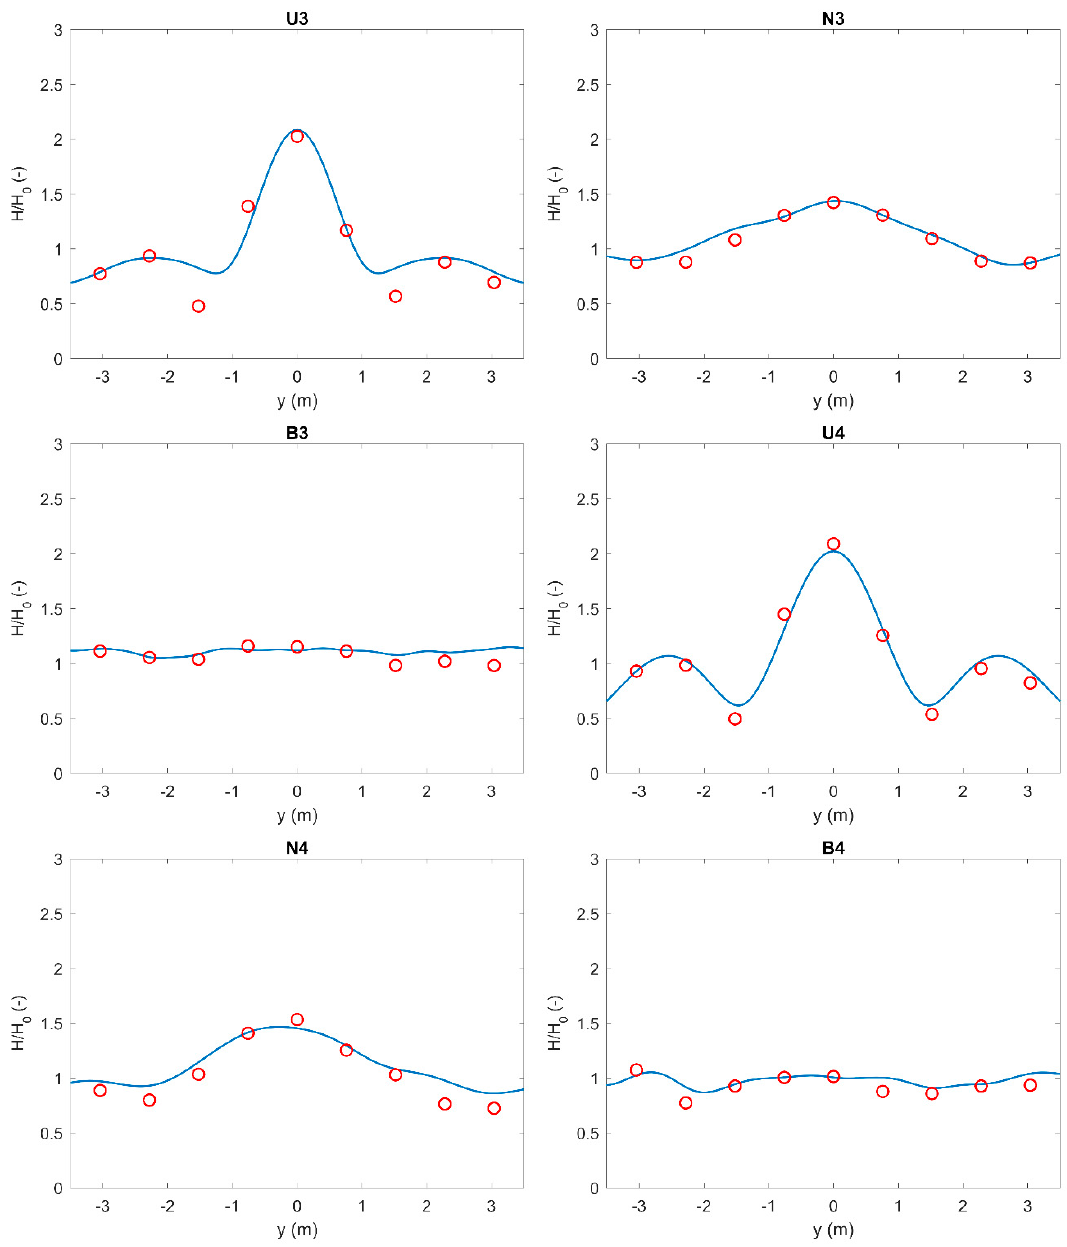
Figure 14. Comparison of normalised wave heights, H/H 0 , between numerical model results (blue solid lines) and experimental data (red circles) along the measurement transect of Figure 12. for the test cases of non-breaking waves of Table 1. Table 2. Root mean square error (RMSE) and skill factor of the normalised wave heights.